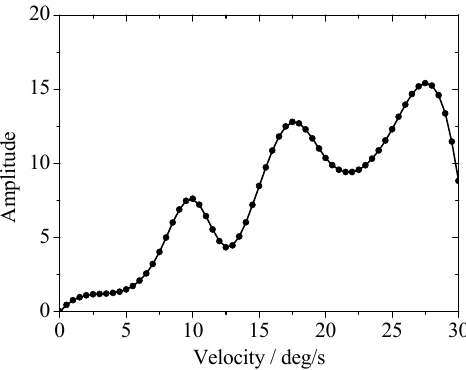
Figure 10. The amplitude of torsional vibration of planet carrier at different rotational velocities.